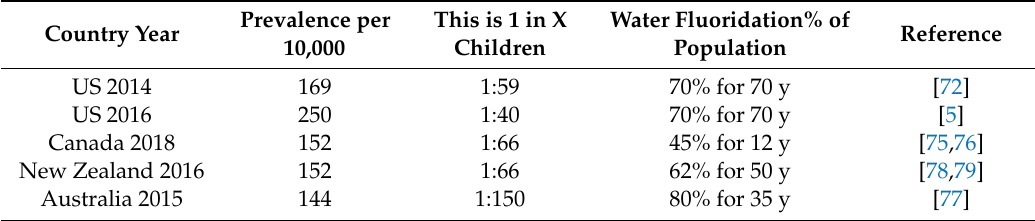
Table 1. Current ASD prevalence in countries with water